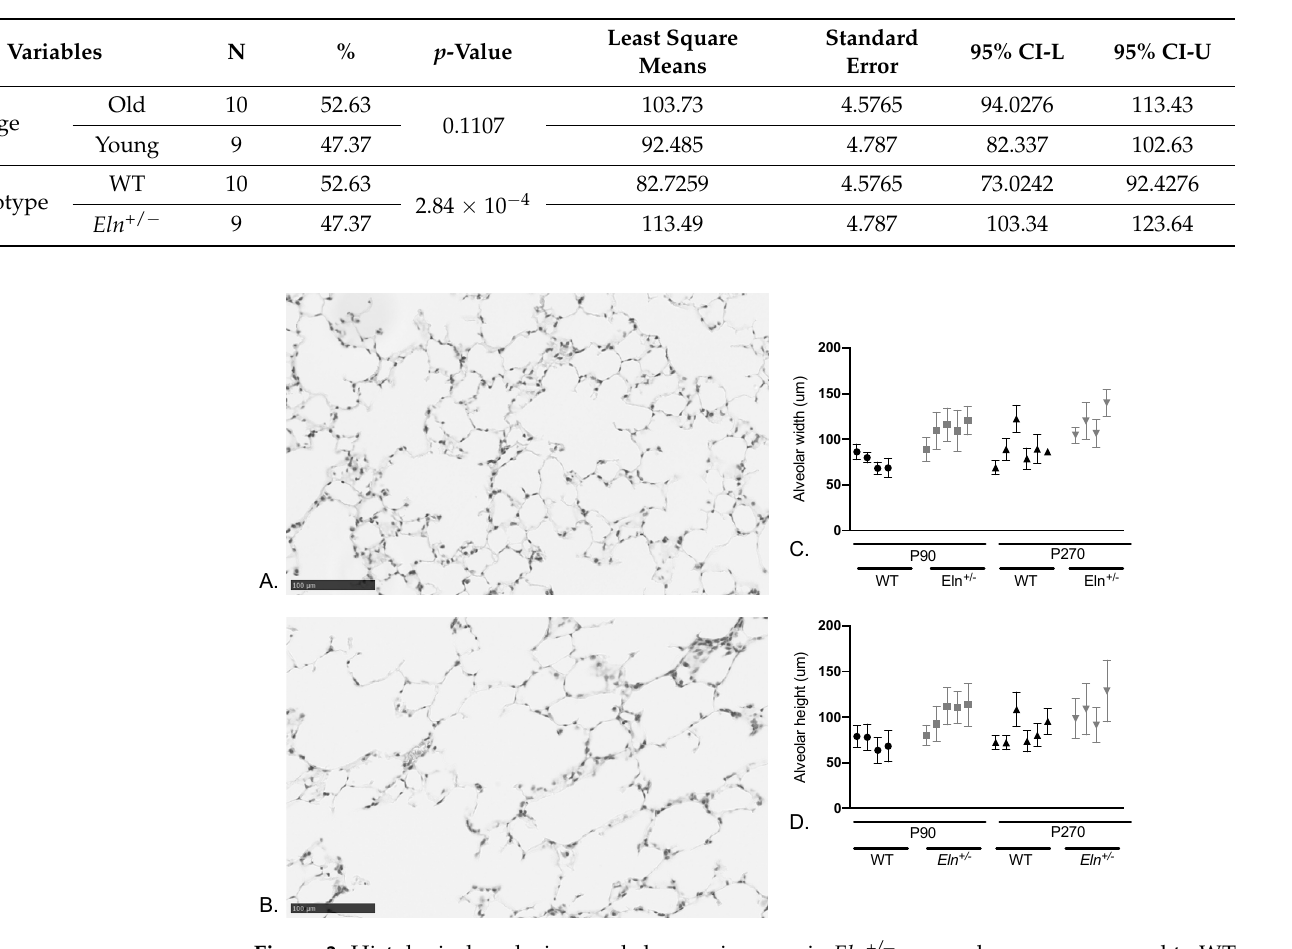
Table 3. Linear mixed effects model results for horizontal intercepts. Eln +/ − mouse lungs have larger airspaces, however, there is no statistically significant difference in airspace size with age. See Table S2 in the online data supplement for vertical intercept results. Abbreviations: 95% CI-L: 95% confidence interval lower limit, 95%% CI-U: confidence interval upper limit.